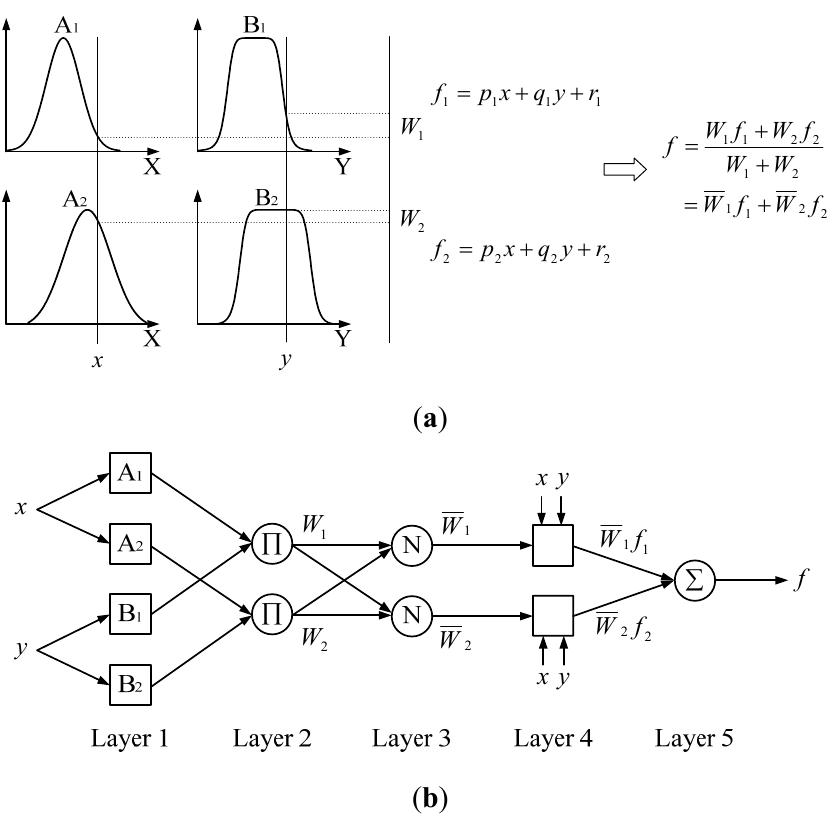
Figure 3. ( a ) Two-input first-order Sugeno fuzzy model with two rules. ( b ) Equivalent ANFIS architecture